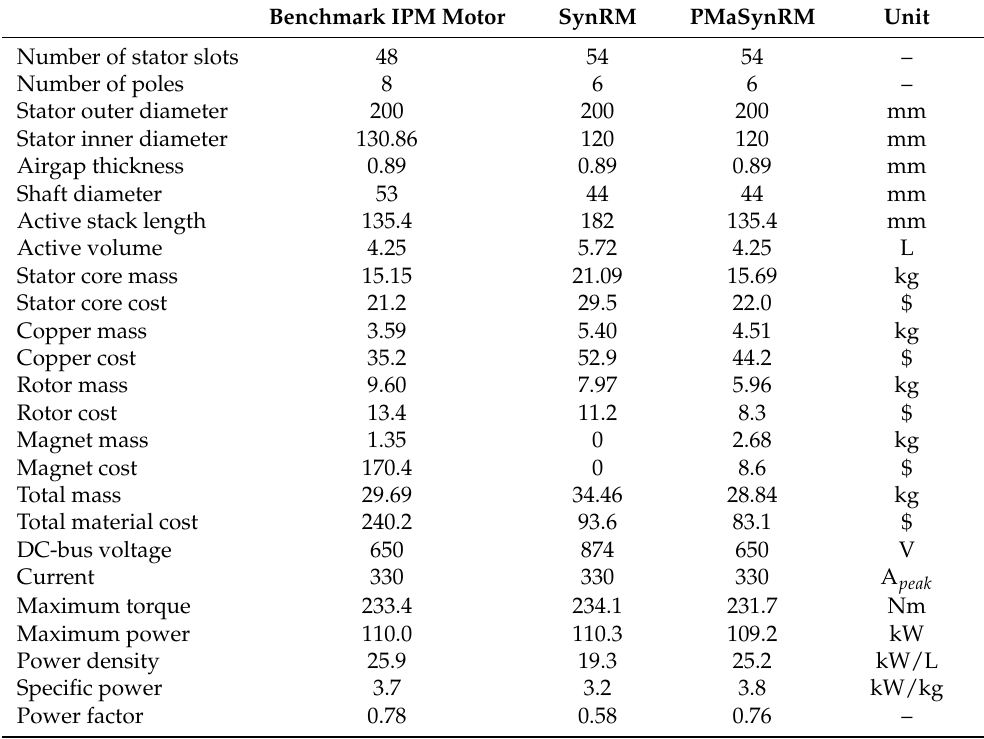
Table 4. Main Design Characteristics and Performance Comparison of the Three